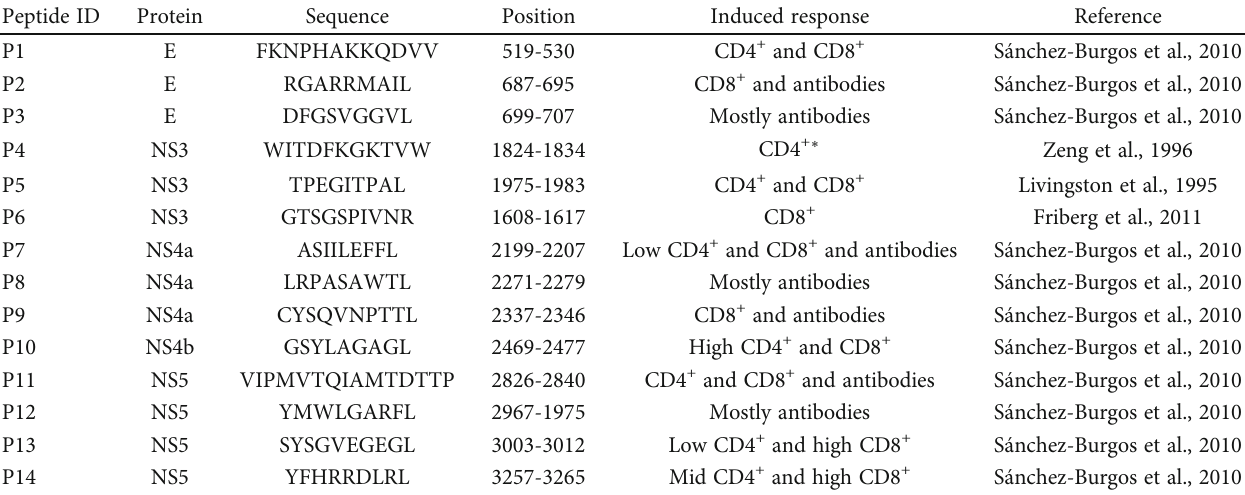
Table 1: Characteristics of dengue virus peptides used in this